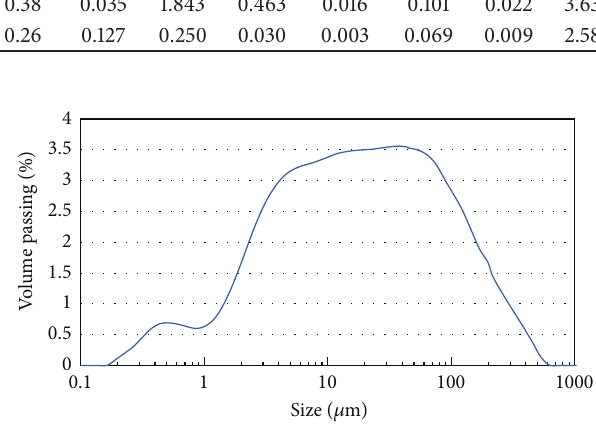
Figure 1: Particle size distribution of fly ash.